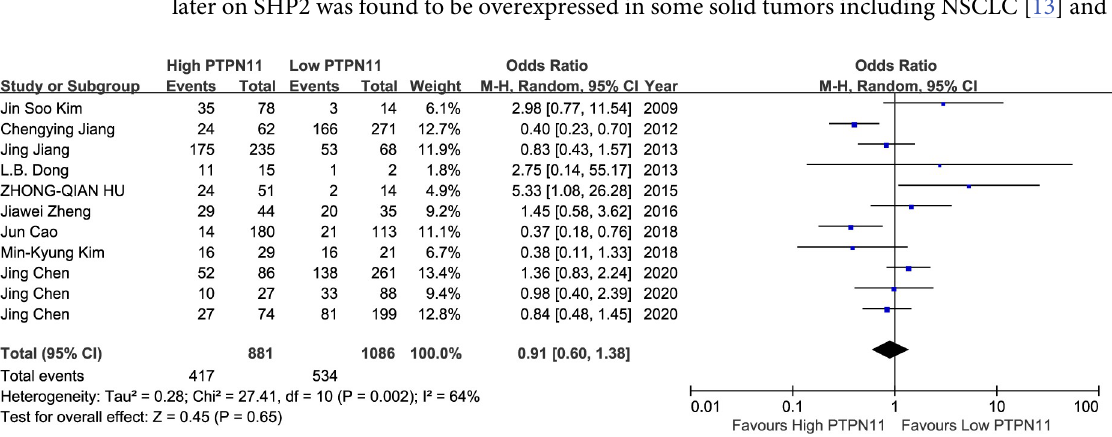
Fig 2. A forest plot for the association between SHP2 expression levels with clinical